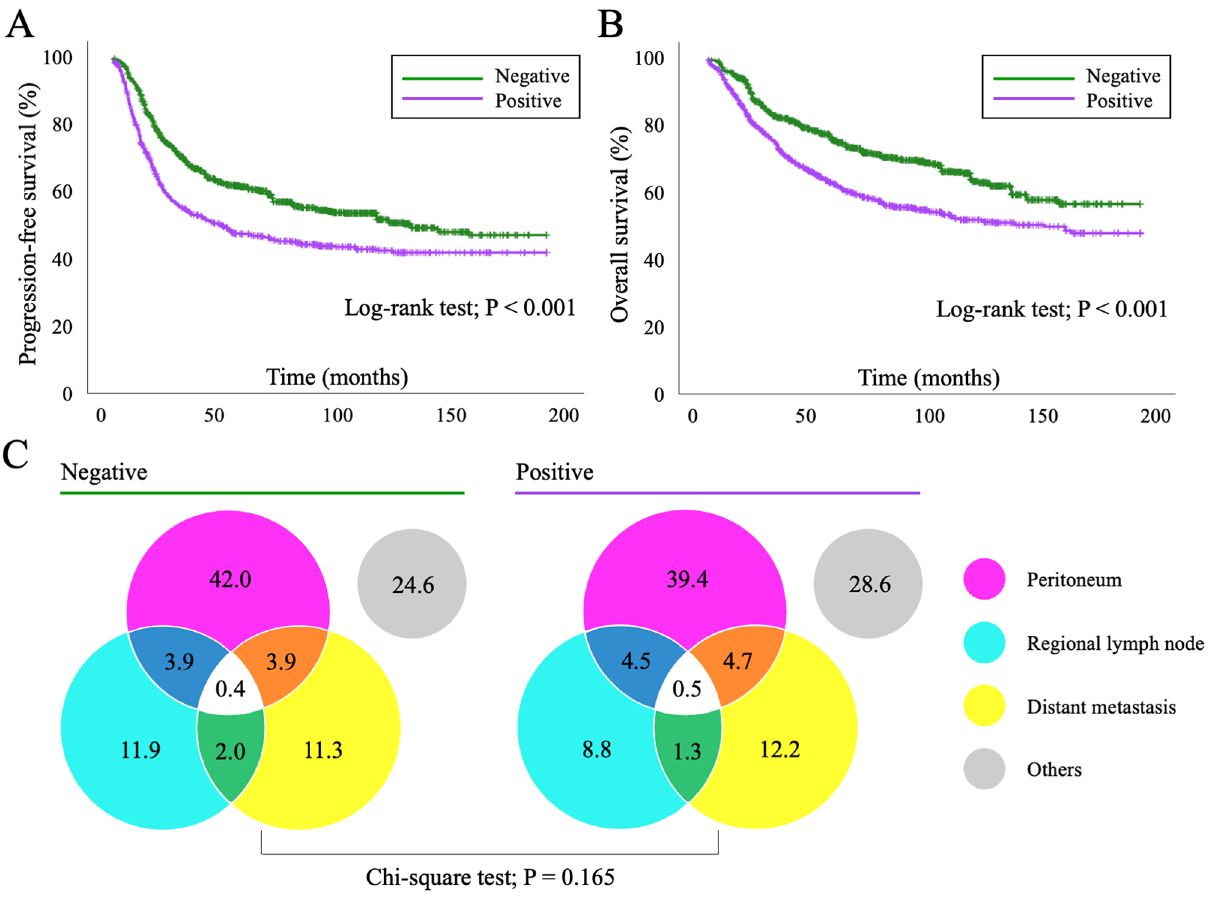
Figure 1. ( A , B ) Propensity score-adjusted Kaplan–Meier curves for progression-free and overall survival in epithelial ovarian cancer patients with and without positive ascites cytology. P values were estimated by the Log- rank test. ( C ) Adjusted ratios for the site of recurrence in patients with and without positive ascites cytology are shown as a Venn diagram. P values were estimated by the chi-squared